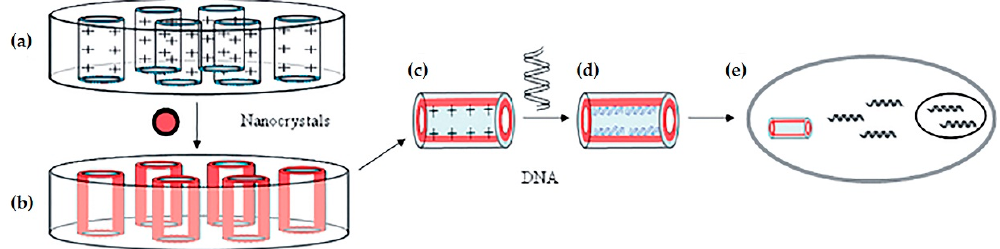
Figure 4. Schematic illustration of the fluorescent SNTs preparation and its application in gene delivery: ( a ) The anodic Al 2 O 3 membrane coated with a silica layer is modified with APTMS to form a cationic surface; ( b ) Nanocrystals are incorporated onto the polycationic surface. An additional silica layer and a subsequent APTMS coating are layered over the nanocrystals; ( c ) The SNTs with polycationic inner surfaces are generated by removal of the membrane; ( d ) pDNA is complexed into the nanotubes; ( e ) The complexed system enters the cell and the DNA is released and transcribed in the nucleus. Reproduced from [22], with permission from John Wiley and Sons.